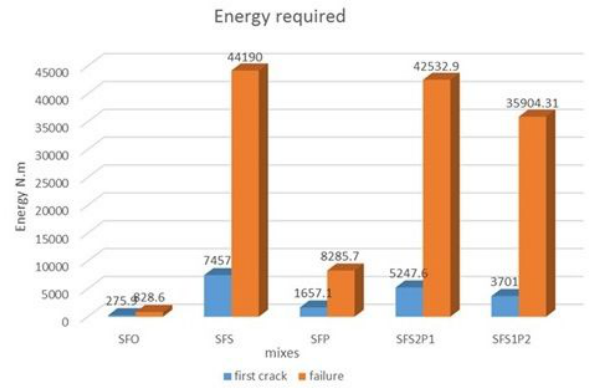
Figure 8: Energy required to first crack and failure